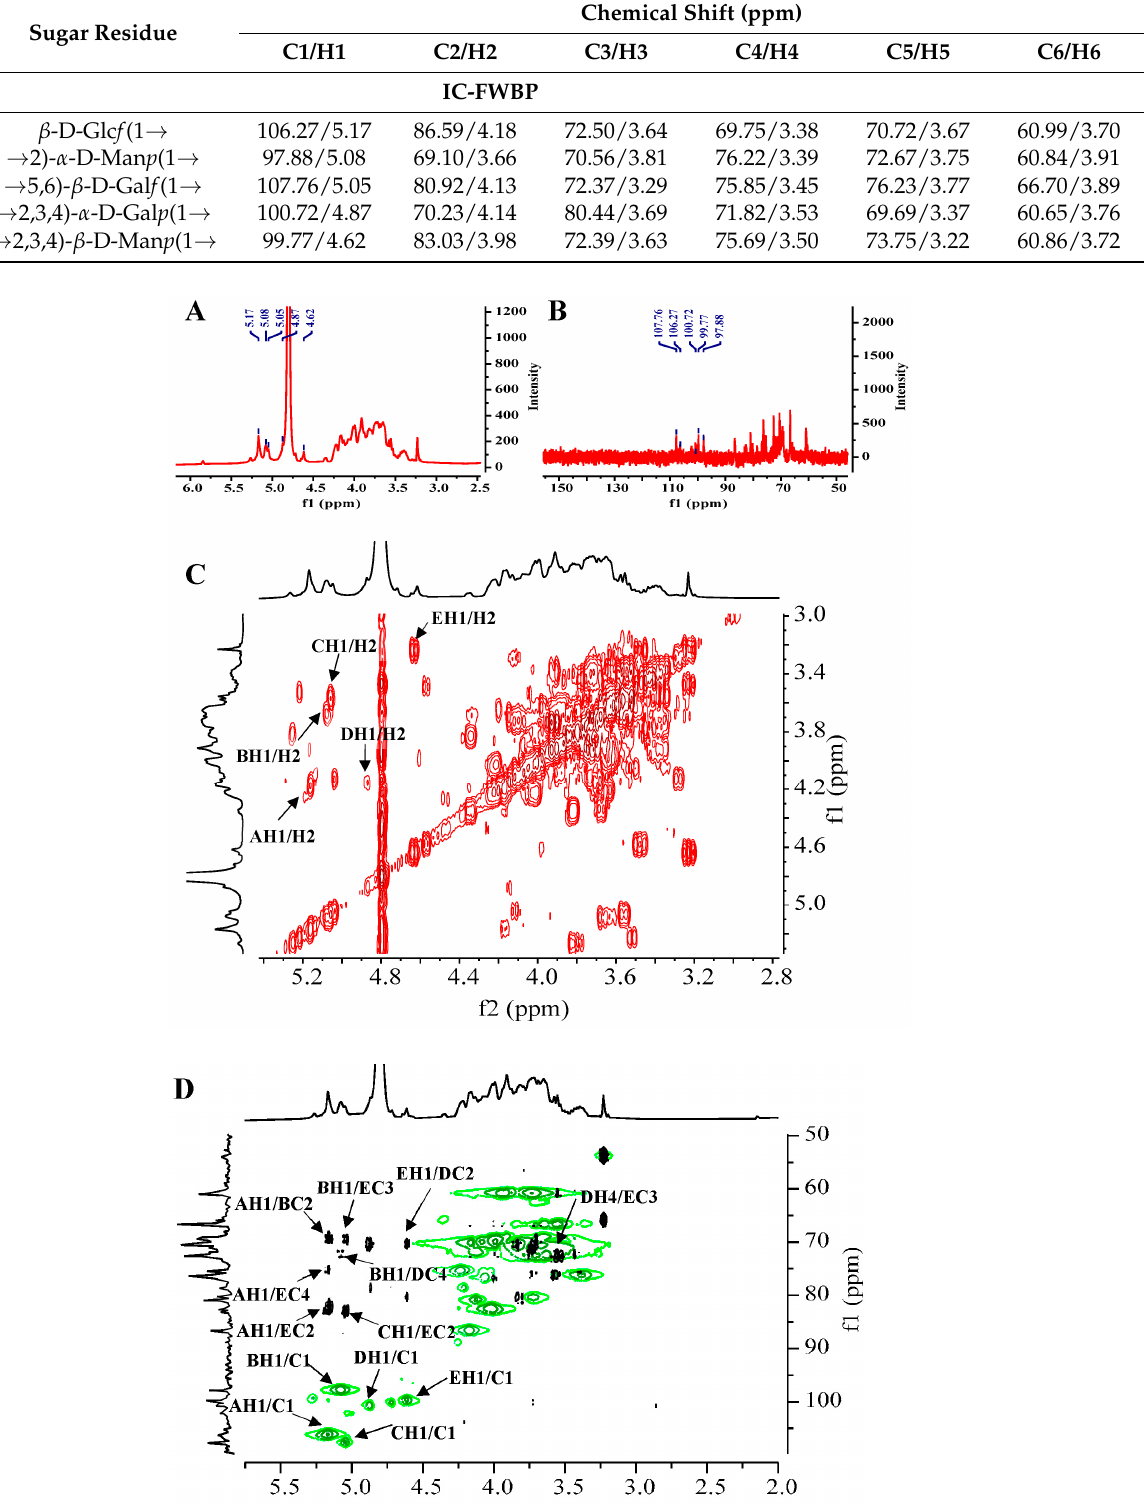
Figure 3. 1D and 2D NMR spectra of the IC-FWBP ( A – D ). ( A ) 1 H NMR spectra; ( B ) 13 C NMR spectra; ( C ) 1 H- 1 H COSY spectra; 1 H- 13 C HSQC spectra (in green color) and 1 H- 13 C HMBC spectra (in black color) were overlapped in ( D ).